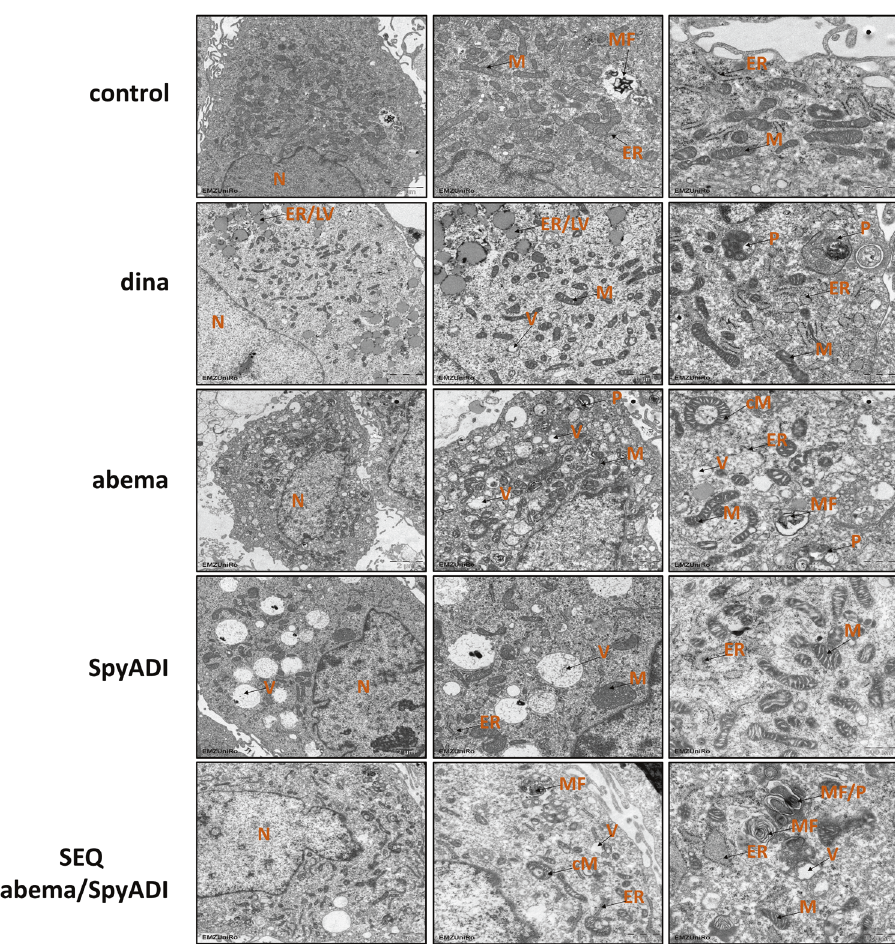
Fig. 2 Transmission electron microscopy. Pellets of HROG05 cells were harvested after the indicated treatments and embedded for electron microscopy as described in Materials and Methods. Ultrastructural changes were examined, focusing on ER and mitochondrial morphology, signs of autophagy, and processes associated with cell death. Shown are representative images of untreated cells compared to various treated cells (scale bars: 1 – 2 µm). The left image panel provides an overview of the treated cells in each case (scale bar: 2 µm) with higher magni fi cation shown in the middle panel (scale bar 1 µm), respectively. Images on the right provide additional information about treatment- speci fi c effects, such as vacuoles, altered structure of mitochondria or abnormal ER (scale bar: 500 nm). ER endoplasmic reticulum,